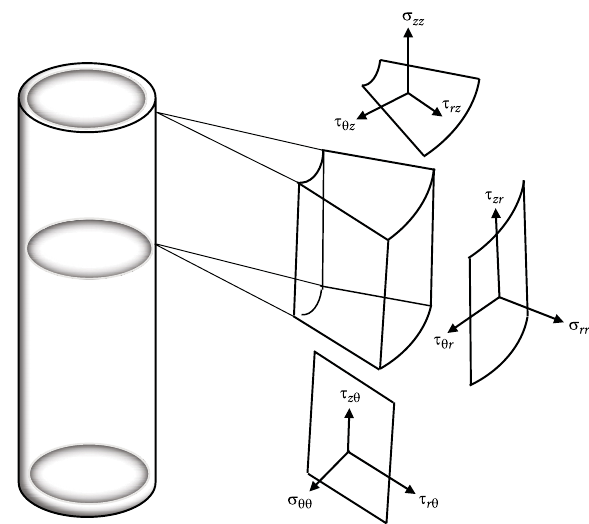
c)Figure 2. Stress on different plane around the